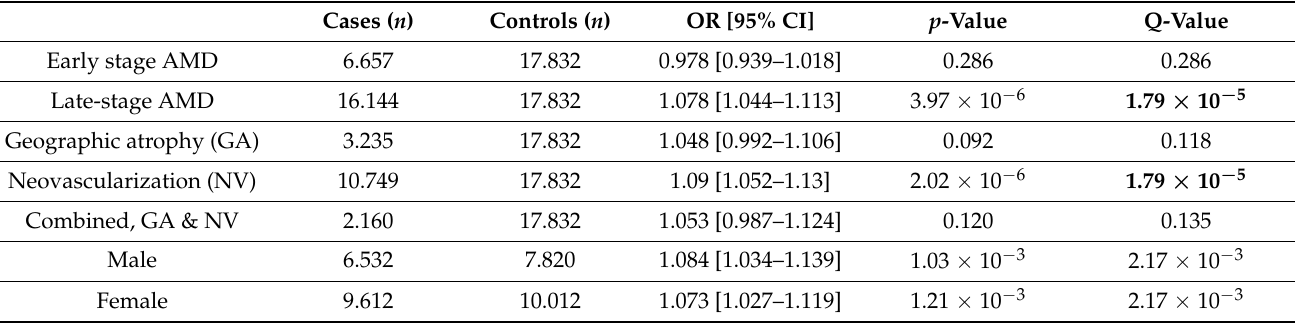
Table 1. Association of rs704 with AMD subtypes.